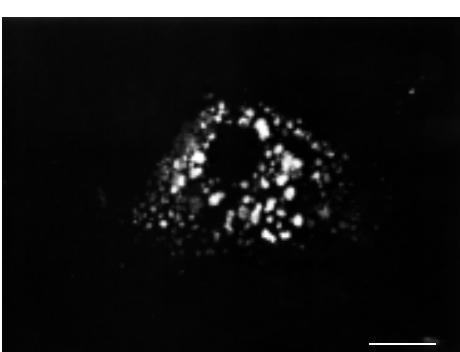
Figure 2 - Effect of the endocy- tocis inhibitor, phenylarsine ox- ide (PAO), on the cell surface distribution of bound fluo-der- morphin. COS-7 cells trans- fected with cDNA encoding the mu opioid receptor were incu- bated for 45 min, at 37 o C, with 10 nM fluo-dermorphin in the presence of 10 µM PAO. Note how the bound fluorescent mol- ecules form a single large clus- ter at one pole of the cell (ar- row). Scale bar: 5 µm.